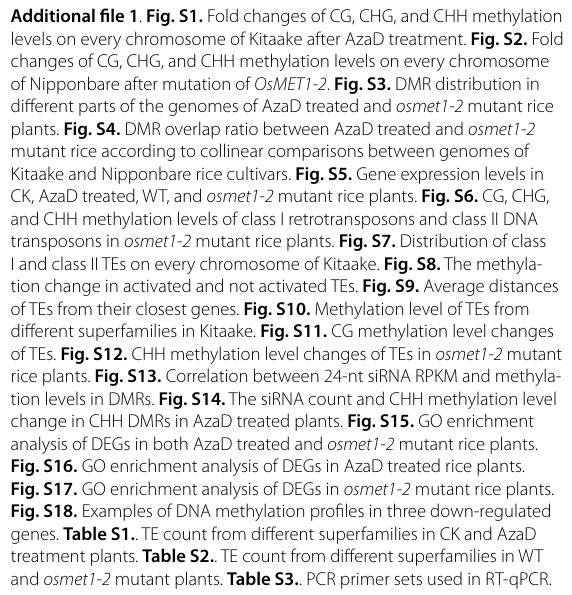
Fig. S16. GO enrichment analysis of DEGs in AzaD treated rice plants. Fig. S17. GO enrichment analysis of DEGs in osmet1-2 mutant rice plants. Fig. S18. Examples of DNA methylation profiles in three down-regulated genes. Table S1. . TE count from different superfamilies in CK and AzaD treatment plants. Table S2. . TE count from different superfamilies in WT and osmet1-2 mutant plants. Table S3. . PCR primer sets used in